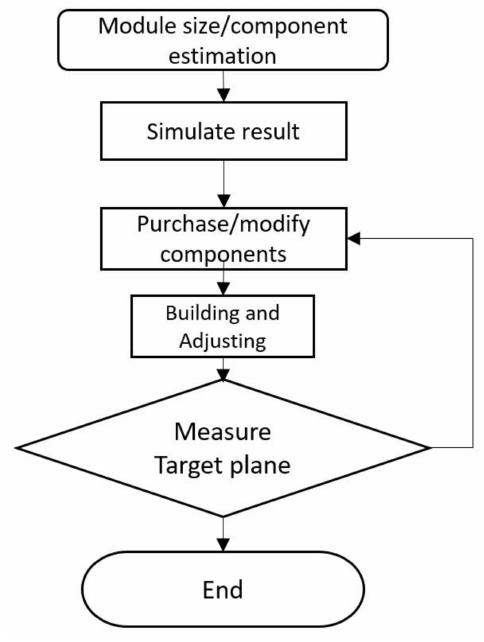
Figure 3. Flow chart of the proposed optical/mechanical